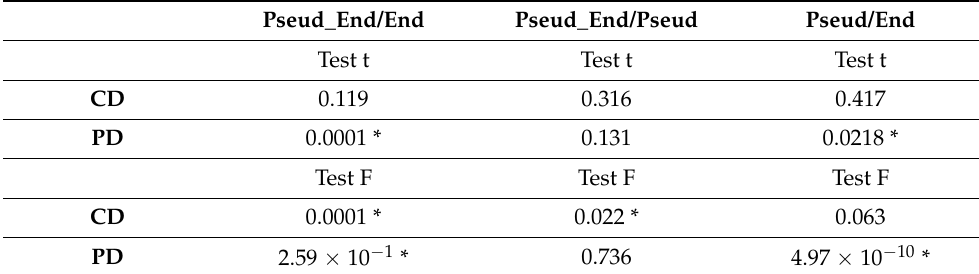
Table 2. Statistical analyses results. * indicates p <